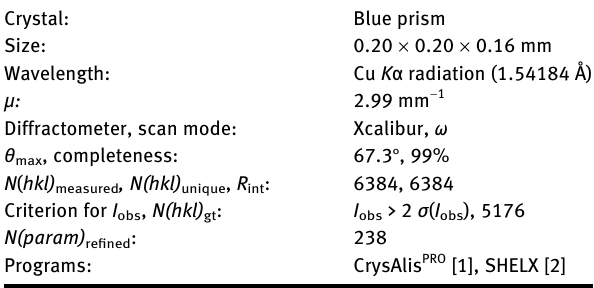
Table  : Data collection and